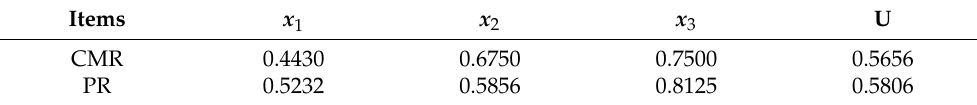
Table 11. Comprehensive evaluation